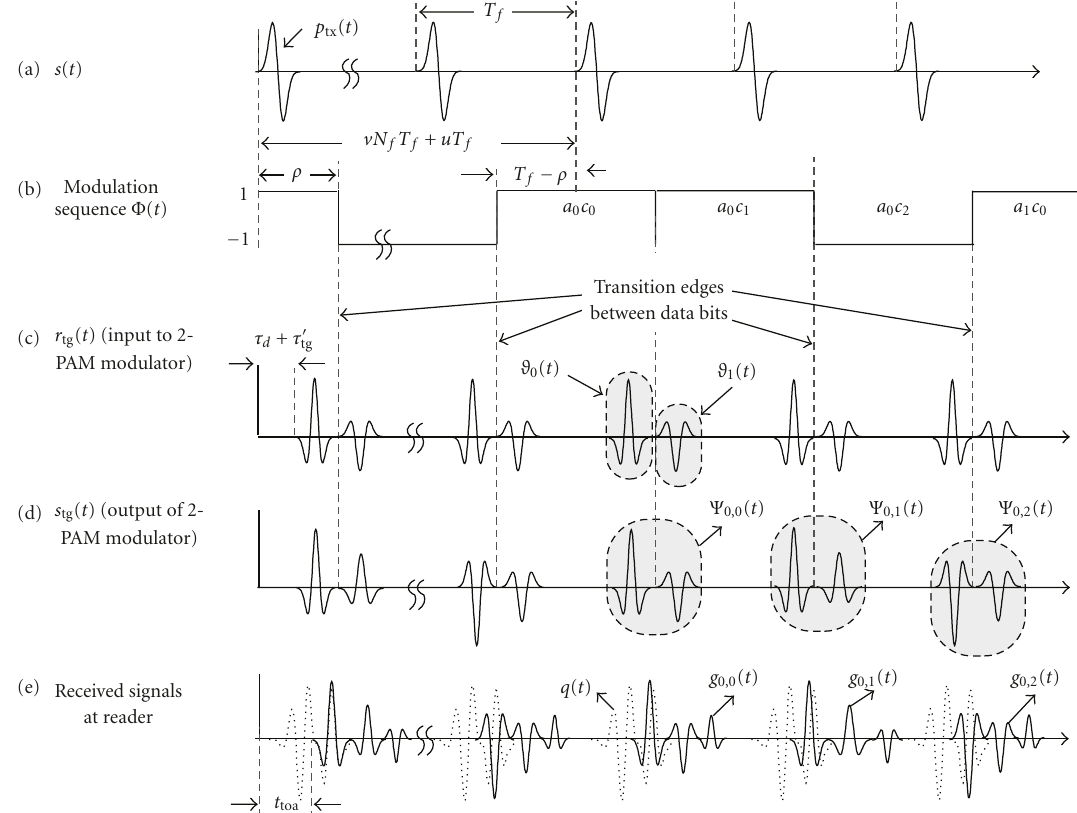
Figure 2: Transmited/received signals present at various stages of the RFID system. (For (e), the clutter signal and the tag response are displayed